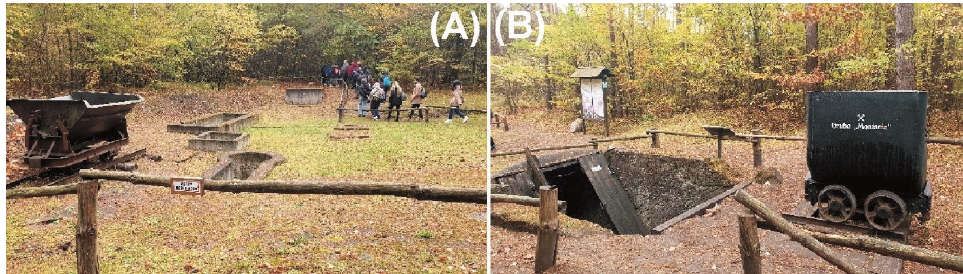
Figure 5. Mining relicts after the „Montania” mine. ( A )—coal washing tanks, ( B )—dip heading.